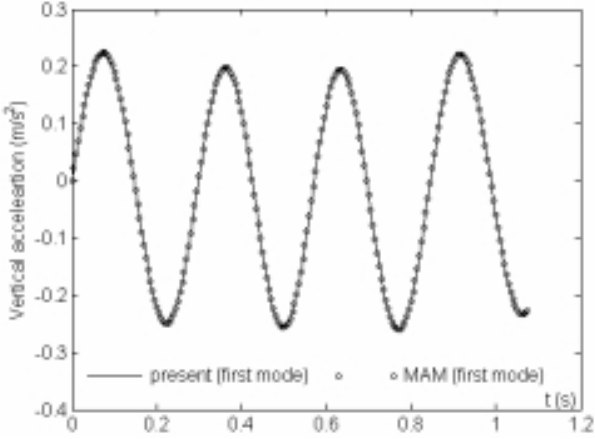
Fig. 6. The time history of vertical acceleration of midpoint of